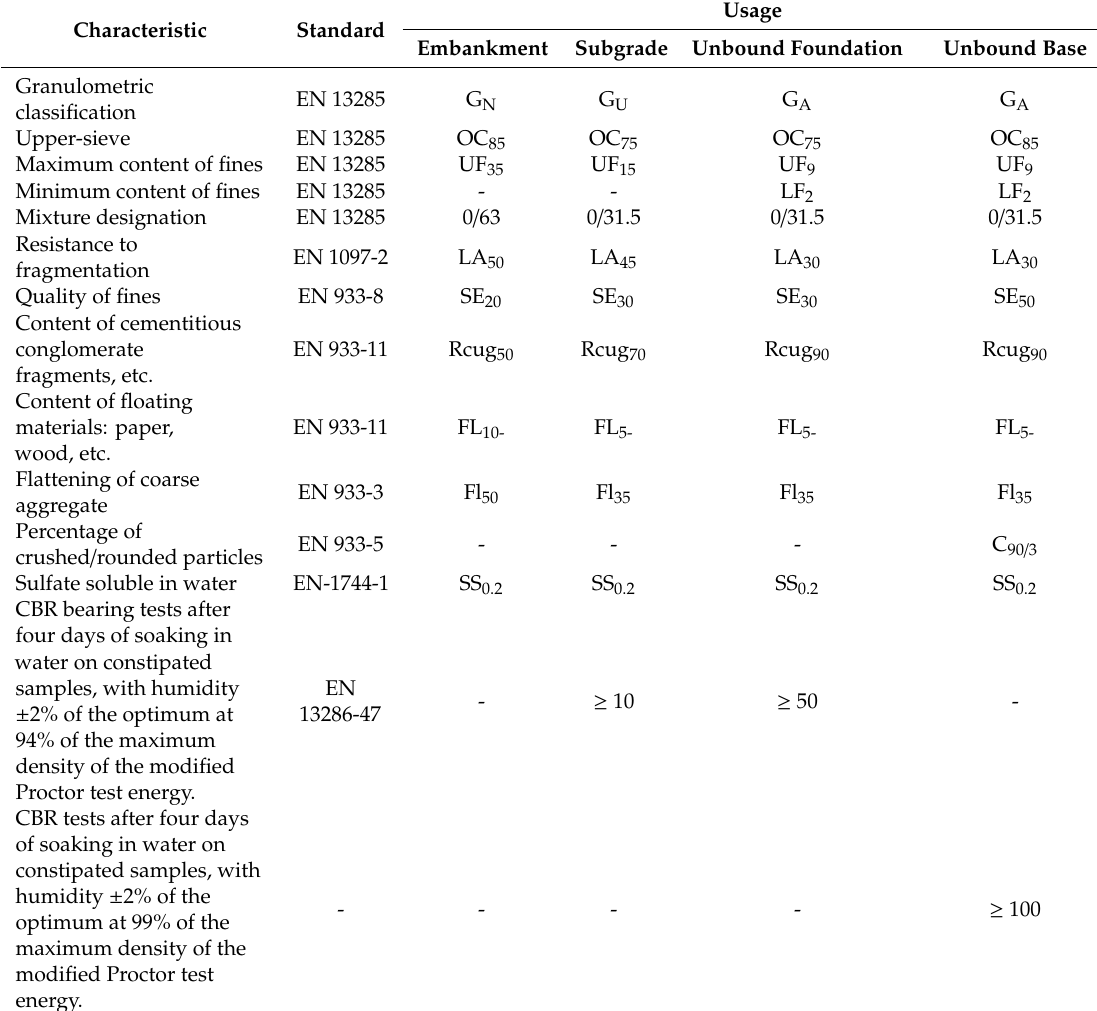
Table 2. Main suitability requirements of unbound mixtures of recycled